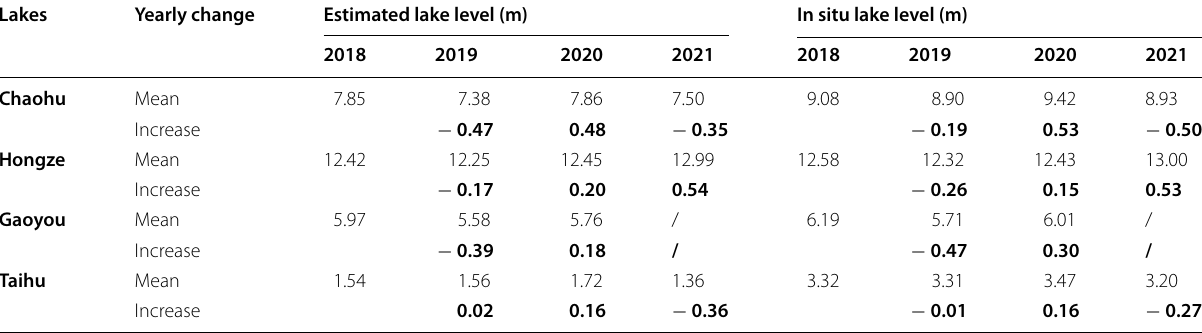
Table 3 Comparisons of yearly means and water level increases acquired by combining ICESat-2 and GEDI between in situ data for four lakes